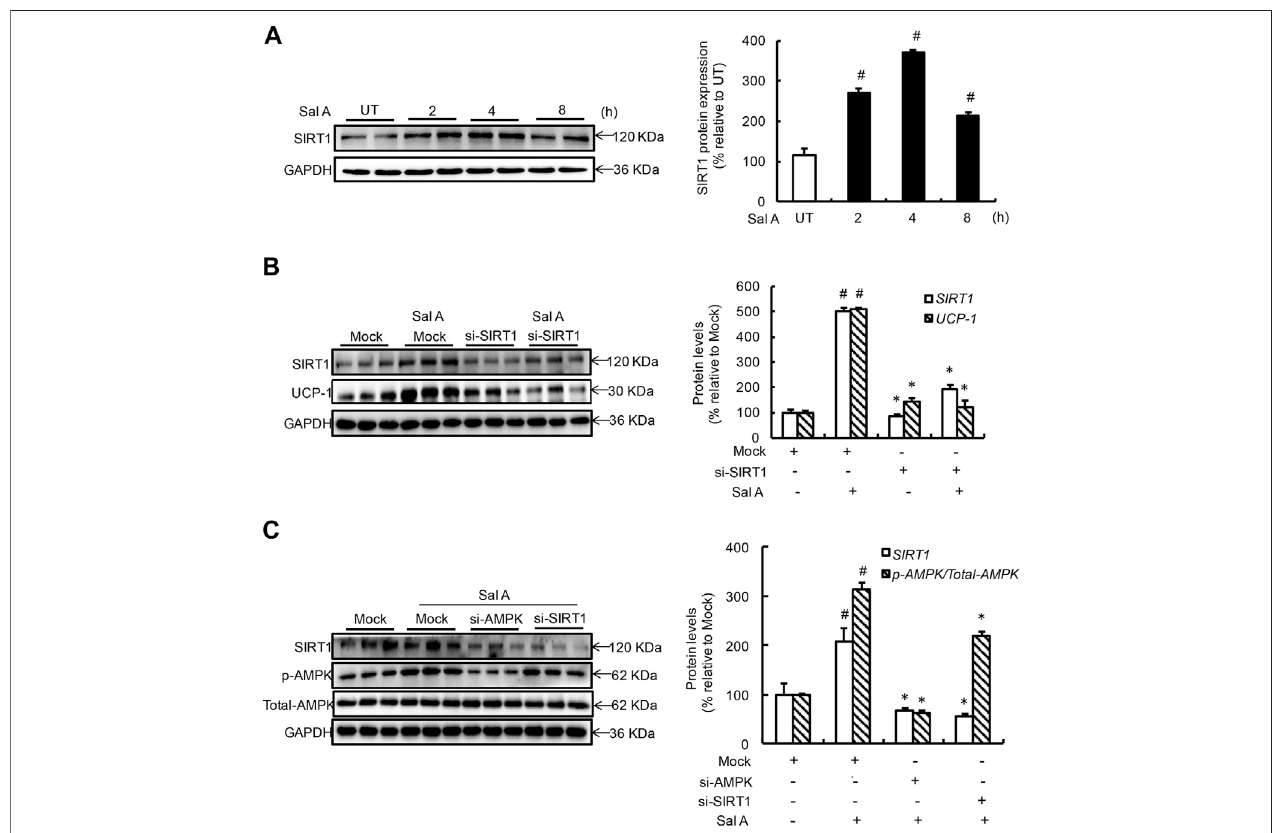
FIGURE3 | SIRT1 increment underliesSal A-induced AMPK activation and UCP-1upregulation. (A) Differentiated C3H10T1/2 adipocytes were treated with Sal A (80 μ M)for 0,2,4and 8 h.IntracellularSIRT1 contentsweredeterminedbyWestern blot. (B) Aftersilencing SIRT1 bysiRNA, cellswereexposedto80 μ MSal Afor4 h. The protein levels of UCP-1 and SIRT1 were detected by Western blot. (C) C3H10T1/2 adipocytes were transfected with siRNA for SIRT1 or AMPK, respectively. Then cellsweretreatedwithSalA(80 μ M)for4 h.TotalcellularlysateswerecollectedfortheimmunoblottingassayforSIRT1, p -AMPKandAMPK.Allvaluesaredenoted as means ± SD from three independent batches of cells. # p < 0.05 vs. the UT or Mock; * p < 0.05 vs. the Sal A treatment group. All groups contain two or three samples ( n (cid:1) 2 or n (cid:1)